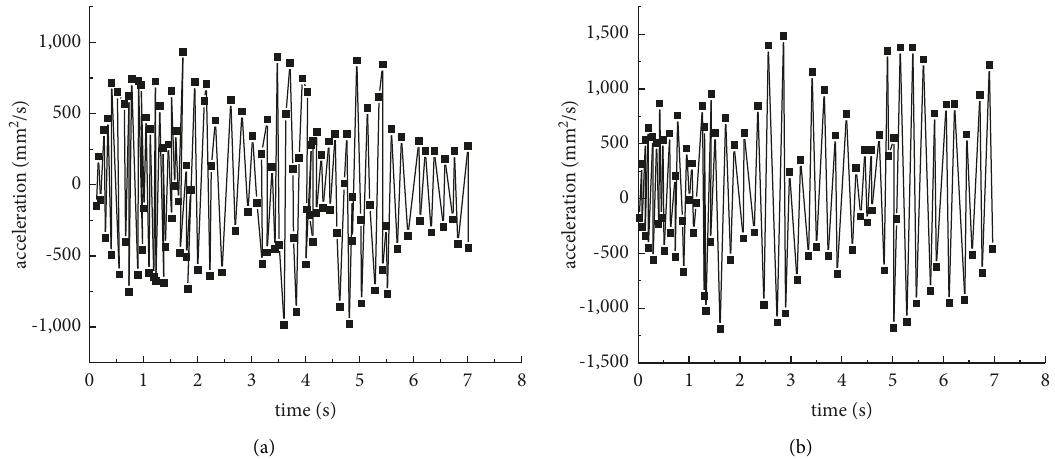
Figure 6: Acceleration-time curve of the staggered truss structure. (a) The time curve with a peak acceleration of 50gal; (b) the time curve with a peak acceleration of 100gal.